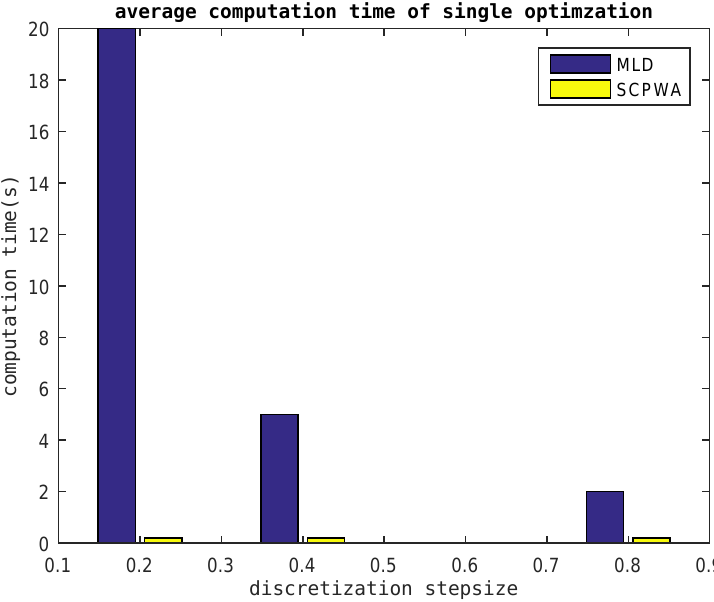
Figure 8. Computation time of a single optimization of MLD and SCPWA with di ff erent discretization step